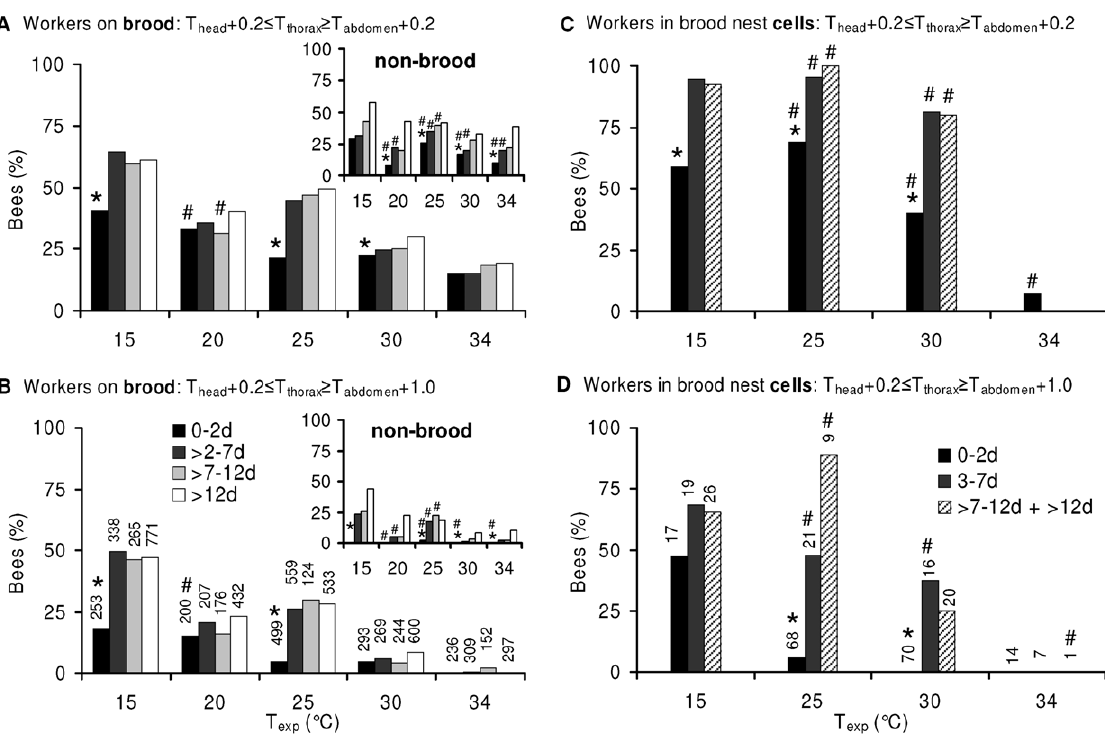
Figure 5. Percentage of endothermic bees in dependence on thermal stress (T exp ). Shading of bars = age. (A-B) Percentage of actively heating workers on brood (main graphs) and non-brood areas (inserts); (C-D) percentage of actively heating workers in open brood nest cells. Parts (A, C) and (B, D) display different levels of endothermy (T thorax -T abdomen ). Number of investigated workers of each age class (=100%) written above each column in (C) and (D). Number of measurements for non-brood areas (inserts) with increasing age: T exp =15 u C: 14, 47, 140, 971; T exp =20 u C: 12, 127, 157, 651; T exp =25 u C: 85, 227, 125, 698; T exp =30 u C: 72, 178, 172, 562; T exp =34 u C: 68, 189, 163, 776. Statistics: *, differences significant (P , 0.05, chi 2 3.841 . 3.94) between 0–2 d old and . 2 d old bees at a certain T exp (at T exp =20 u C, P , 0.1, chi 2 2.706 =3.484). # , differences not significant (P . 0.05) between T exp =15 u C and T exp . 15 u C in each age class; otherwise P , 0.05 (chi 2 6.239 . 6.94 in A, B and chi 2 5.731 . 7.39 in C, D).